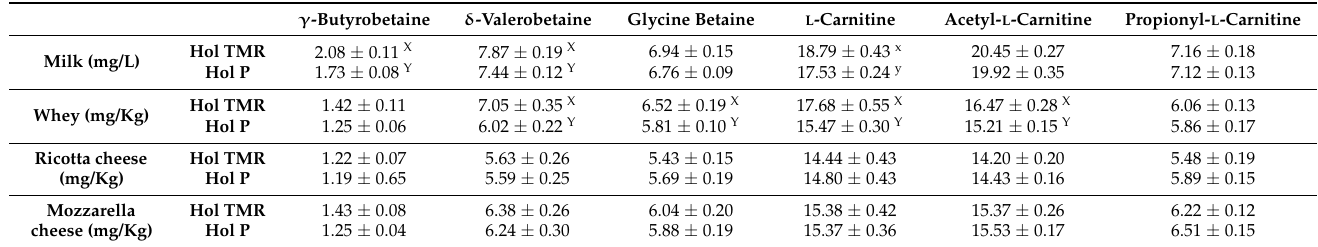
Table 3. Effect of feeding system on health-promoting biomolecules in milk and dairy products. The pairwise contrast involved Holstein (Hol) fed total mixed ratio (TMR) and pasture (P). γ -Butyrobetaine δ -Valerobetaine Glycine Betaine L -Carnitine Acetyl- L -Carnitine Propionyl- L -Carnitine